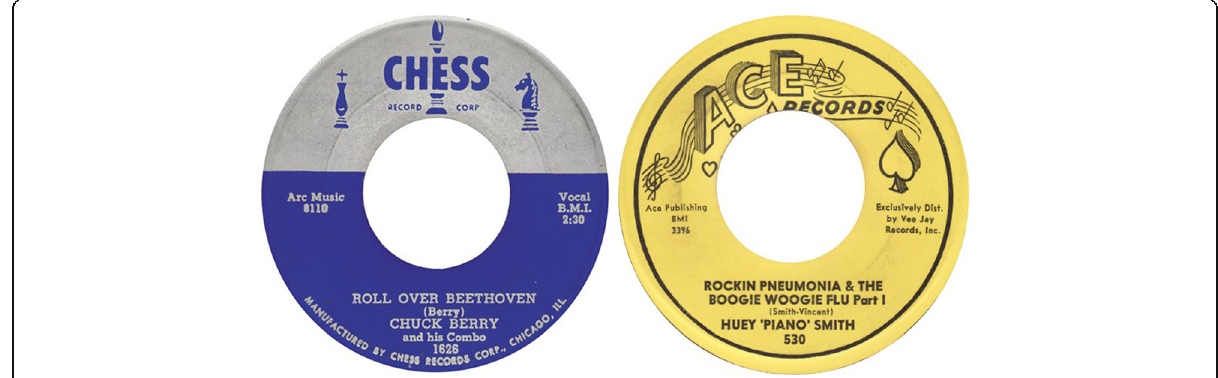
Fig. 1 Chuck Berry ’ s ‘ Roll over Beethoven ’ and Huey ‘ Piano ’ Smith ’ s ‘ Rockin ’ Pneumonia & the Boogie Woogie Flu